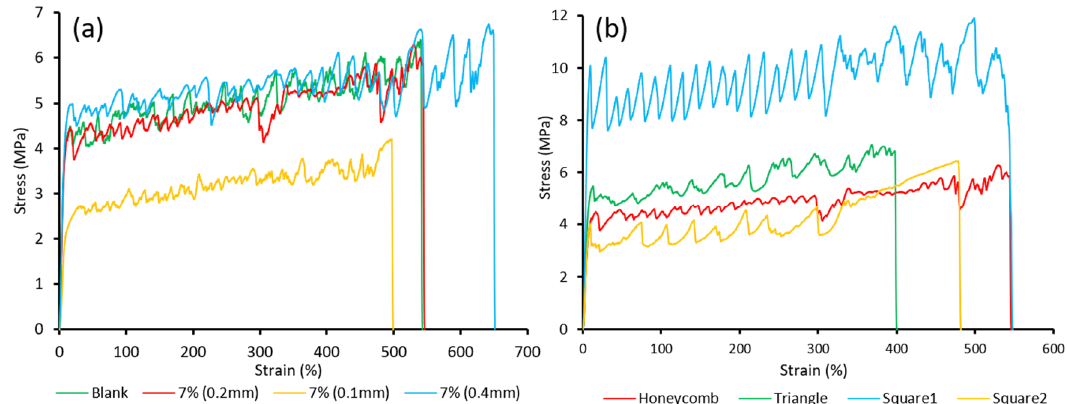
Figure 10. The flexible property of 1% ( w / w ) honeycomb scaffold. 3.3. Assay of Curcumin Loading in PCL Scaffolds The drug content in curcumin-loaded scaffolds was determined using HPLC. As shown in Table 5, all the scaffolds achieved percentage recovery of 91–103%, which was within the general USP range of 90–110% of the labelled quantity [44]. Despite different levels of drug loss, efficient drug loading in the scaffold was achieved with the developed method, including solvent casting, HME, and 3D printing. The low standard deviations of all groups indicate that curcumin was uniformly distributed in the PCL matrix. Table 5. Theoretical and practical amounts, percentage recovery of curcumin in different loading scaffolds ( n = 3). Theoretical Drug Loading